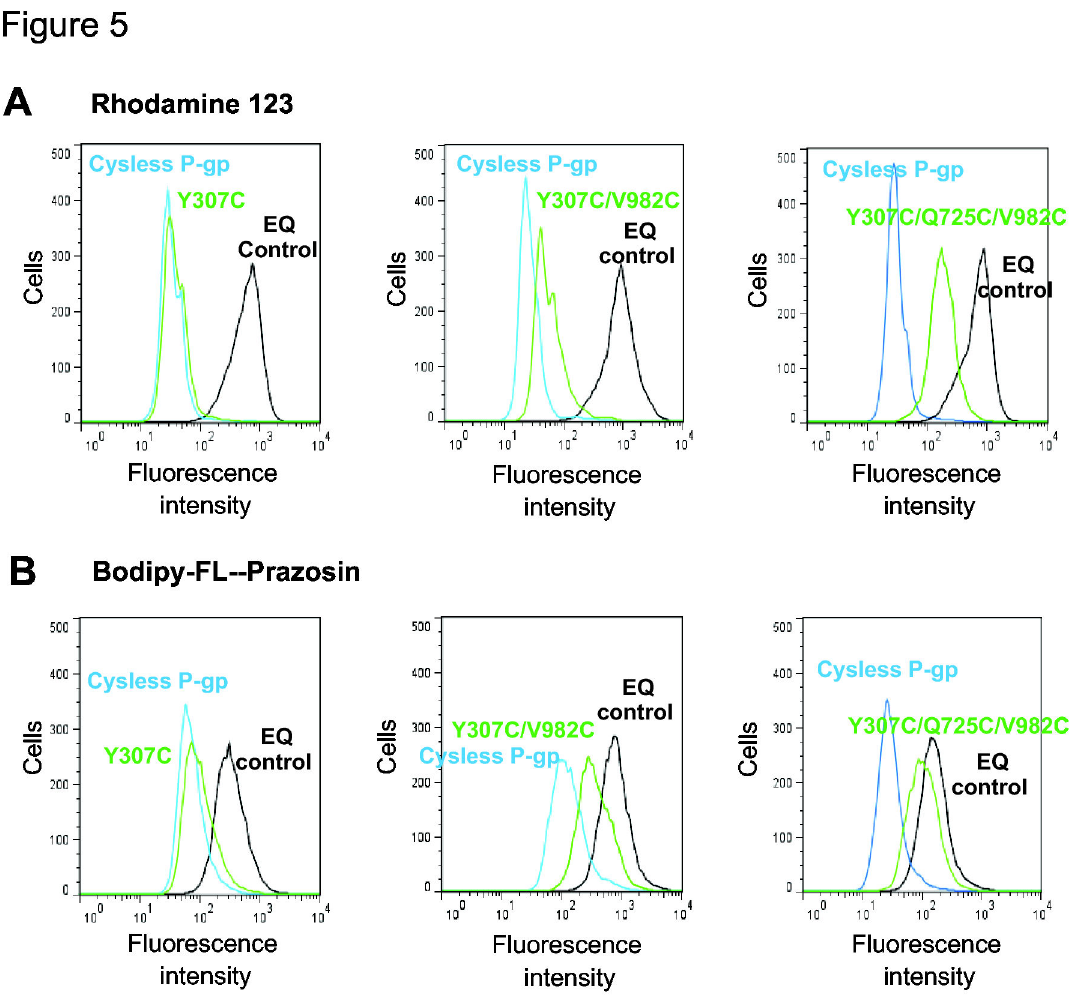
Figure 5. The transport functions of single (Y307C), double (Y307/V982C) and triple (Y307C/Q725C/V982C) mutants are differentially affected. (A) Rhodamine 123 and (B) Bodipy-FL-prazosin accumulation in HeLa cells. The inactive E501Q/E1201Q (EQ) mutant P-gp is used as a control to show completely aborted function as described in Materials and Methods. The HeLa cells expressing mutant-Pgps were incubated with either rhodamine 123 (1.3 µM) or bodipy-FL-prazosin (0.5 µM) for 45 min at 37°C. The cells were washed and subsequently analyzed by flow cytometry as described in Materials and Methods. The histograms show results from a typical experiment. Similar results were obtained in at least 3-4 experiments. The transport function of all mutants with six fluorescent substrates is summarized in Table